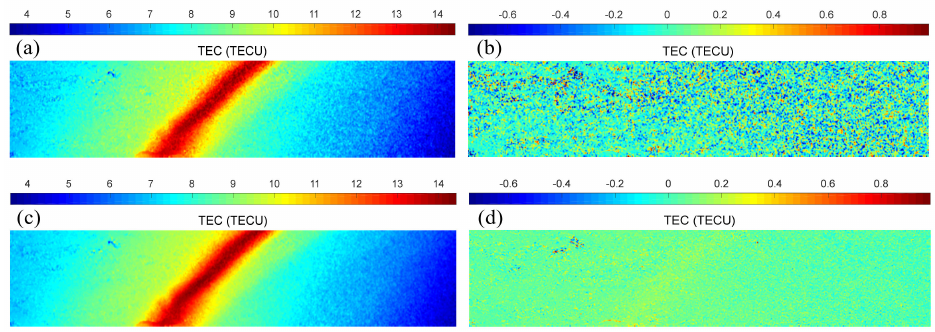
Figure 5. TEC retrieval in Alaska based on L-band SAR ( a ) and P-band SAR ( c ) with low systematic error level. The deviations between the retrieval and the true values (Figure 1c) are shown in ( b , d ).